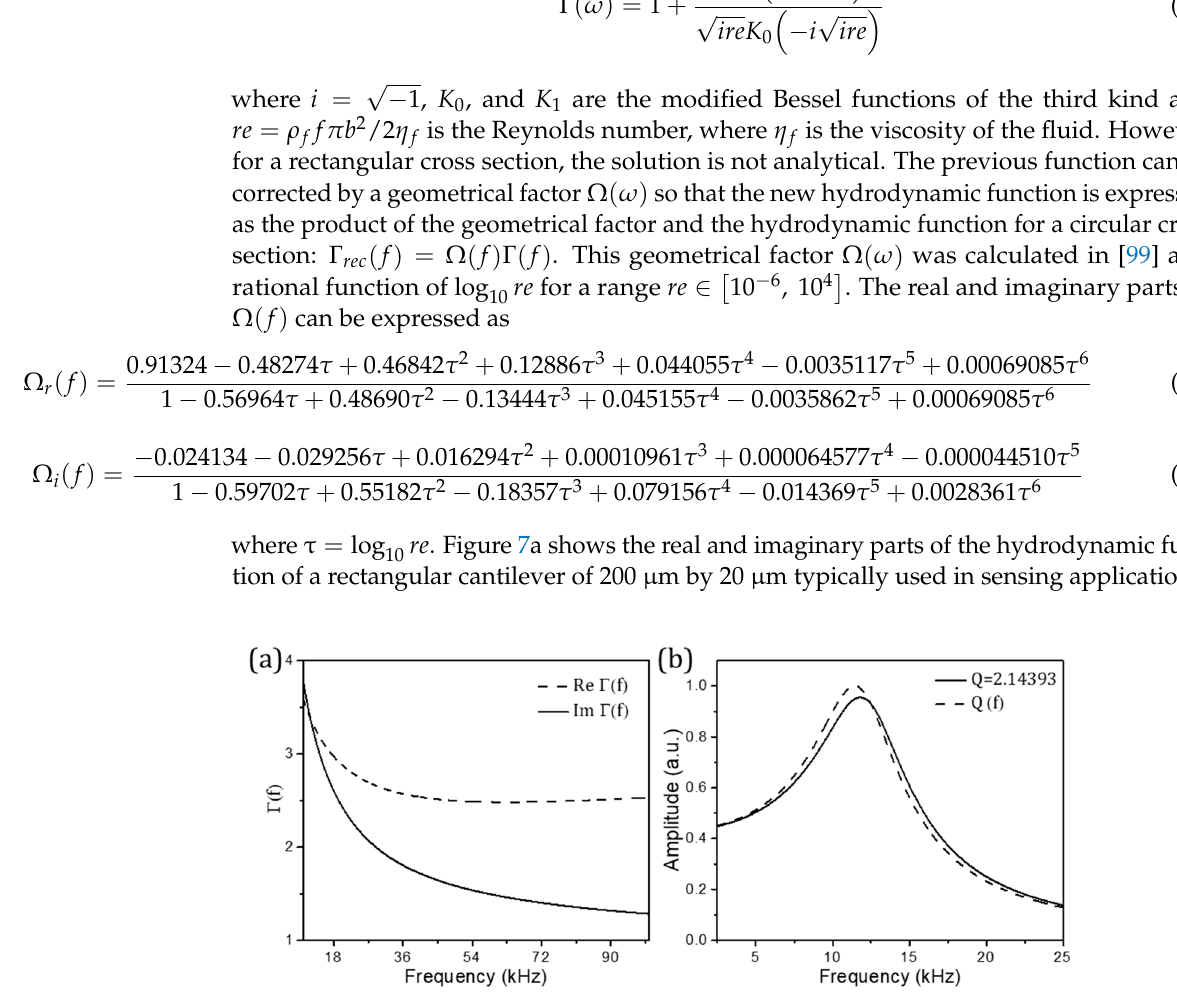
Figure 7. ( a ) Real (solid line) and imaginary (dashed line) parts of the hydrodynamic function as a function of the oscillation frequency for a rectangular cantilever of 200 µm in length and 20 µm in width immersed in water. ( b ) Theoretical simulation of amplitude spectra of two equivalent nanomechanical resonators: one oscillating in vacuum (solid line) and one oscillating in liquid (dashed line). The effective mass and damping constant of the resonator in vacuum were consequently changed to obtain an equivalent liquid immersed resonator.